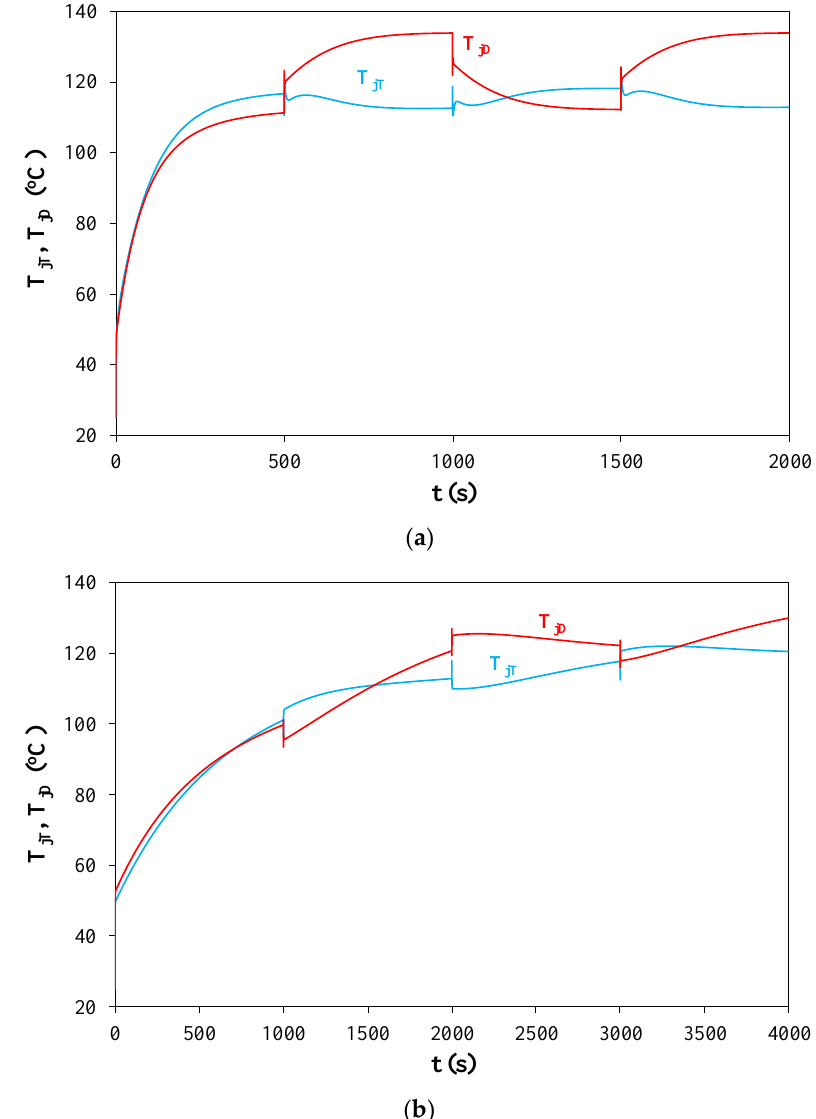
Figure 13. Computed waveforms of the internal temperature of the IGBT and the diode excited by the rectangular pulses train of power dissipated alternatively in these dies for the investigated devices: operating without any heat-sink ( a ); and situated on the heat-sink ( b ). Similar relations between the waveforms T jT (t) and T jD (t) can be observed for the in- vestigated devices situated on the heat-sink. The obtained differences T jD − T jT do not ex- ceed 15 °C.